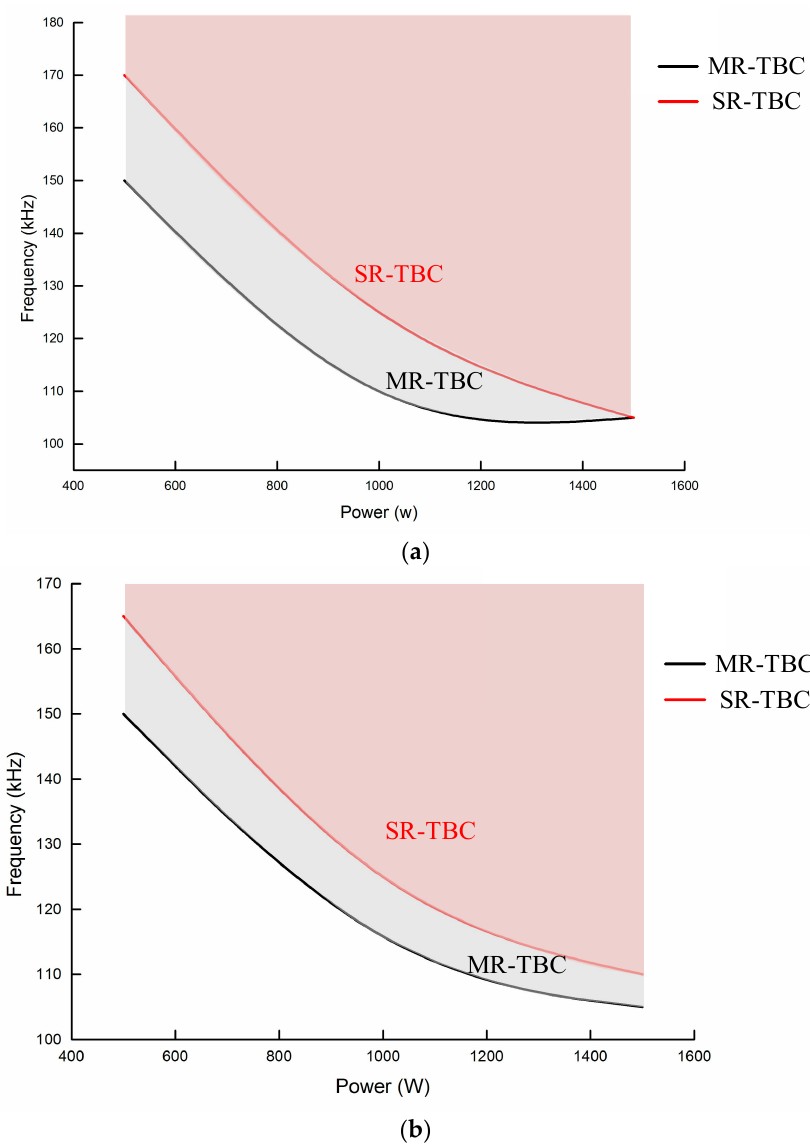
Figure 18 . ZVS realized curve of MR-TBC and SR-TBC ( a ) forward; ( b ) reverse. Figure 18. ZVS realized curve of MR-TBC and SR-TBC ( a ) forward; ( b )